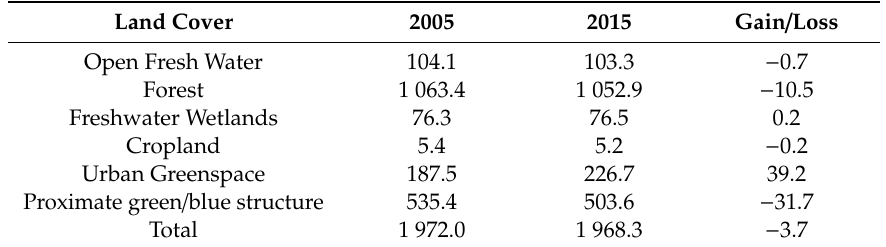
Table 6. Ecosystem service balances from 2005 to 2015 in Stockholm County in million USD